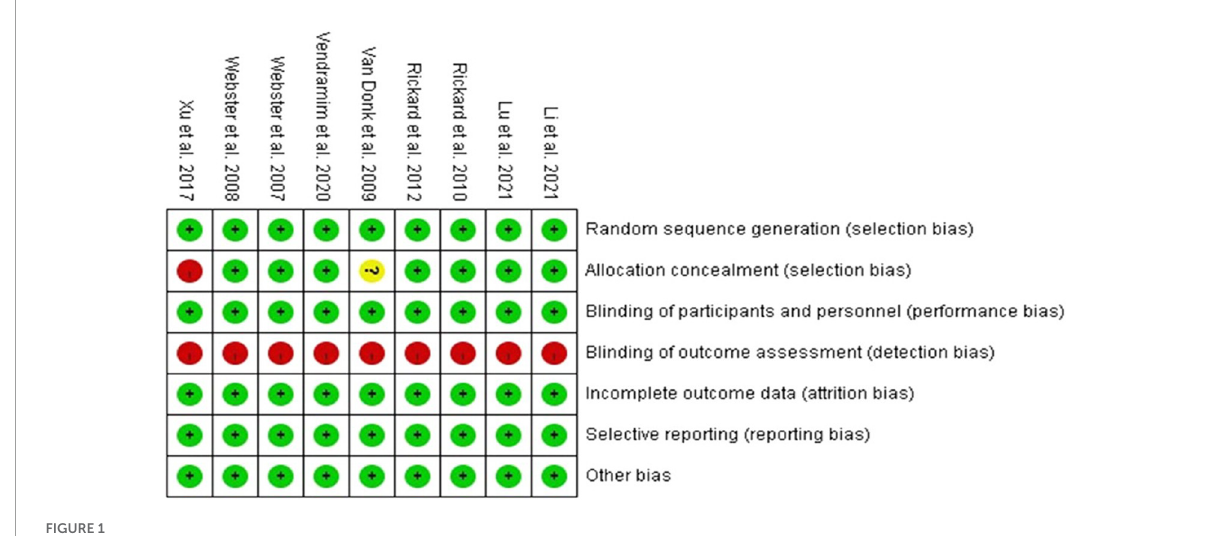
FIGURE1 Algorithm for screening and identifying studies.